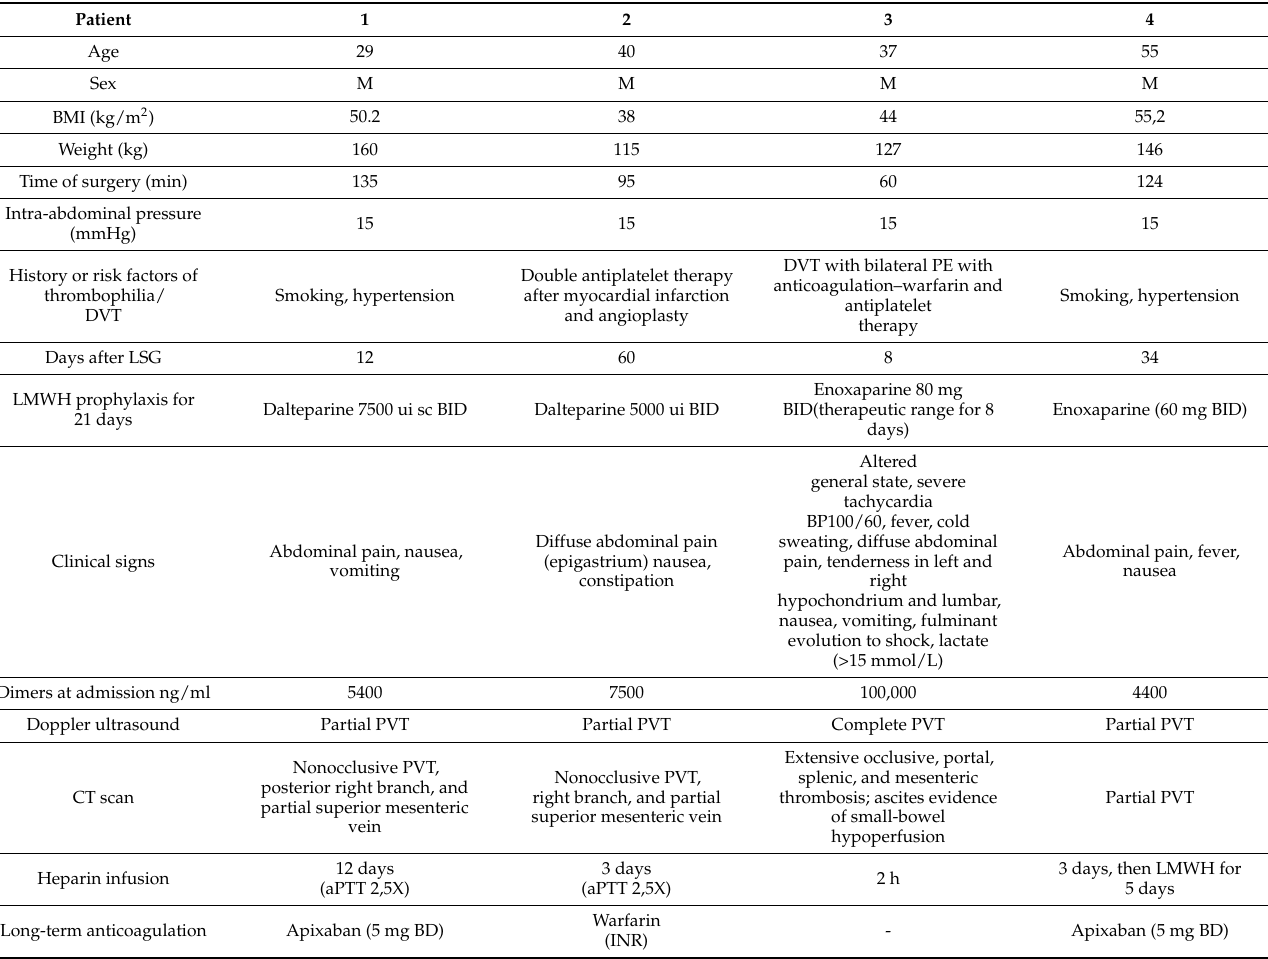
Table 3. Demographics, medical and intraoperative characteristics, diagnosis, treatment, and out- comes of patients with PMVT after LSG in Ponderas